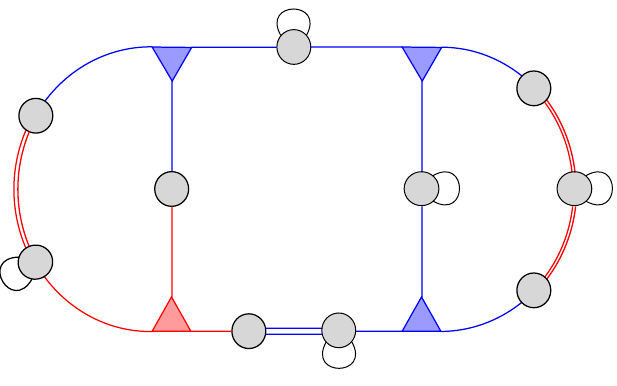
Figure 5 . An example of a genus g = 3